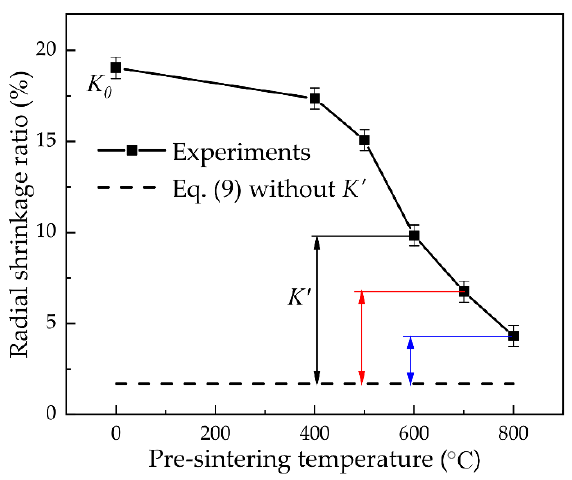
Figure 6. Radial shrinkage ratio versus pre-sintering temperature. The dotted line in Figure 6 represents the linear shrinkage ratio calculated by Equation (9) without K (cid:48) . K 0 equals the linear shrinkage ratio of the agglomerated clusters in the raw powder, 19.05%. The average diameter size of primary particles d 0 is 2.8 µ m,